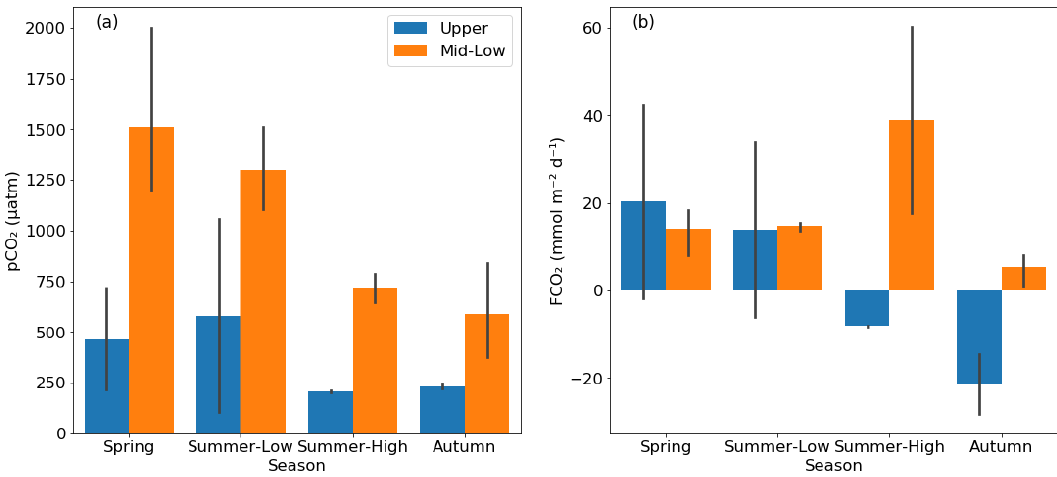
Figure 4. The bar charts showing the pCO 2 ( a ) and FCO 2 ( b ) pattern in different seasons between the upper reaches and the middle-lower reaches in reservoirs. The grey error bars show the range of 95% confidence interval.